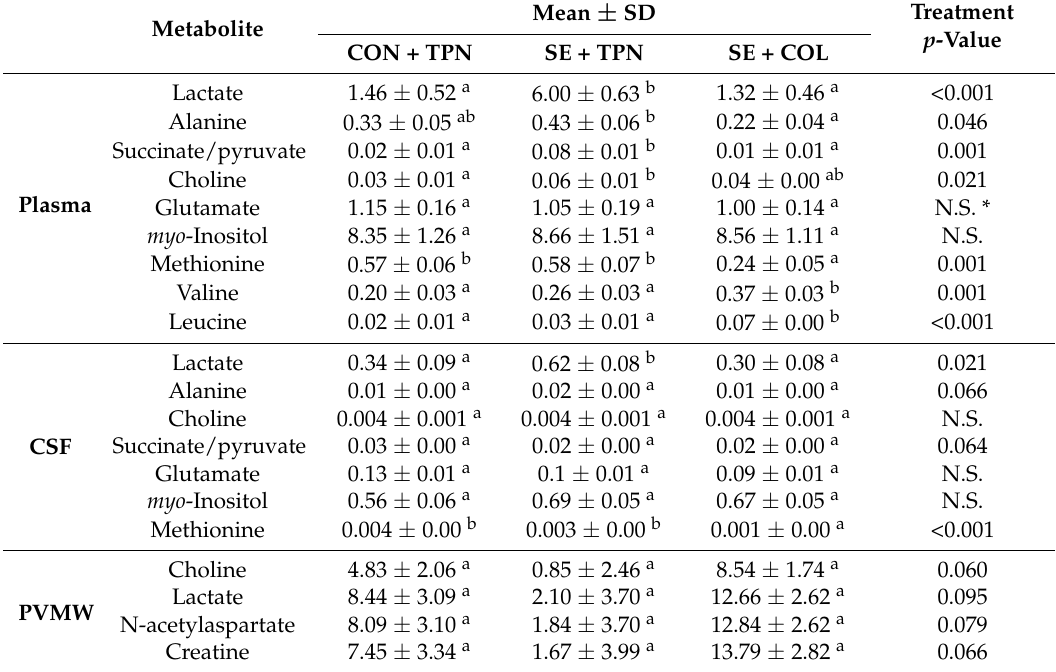
Table 1. Results of two-way ANOVA calculated for metabolites altered under bloodstream infection (BSI) and quantitated by 1 H NMR spectroscopy. The metabolites included were derived from